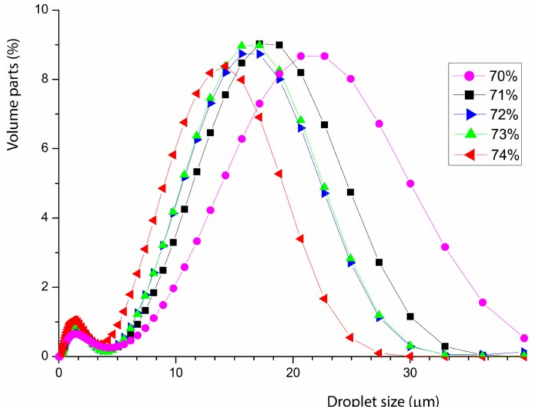
Figure 3. Oil drop size distribution of milk emulsions with varying oil proportions 70% w / w to 74% w / w and fresh